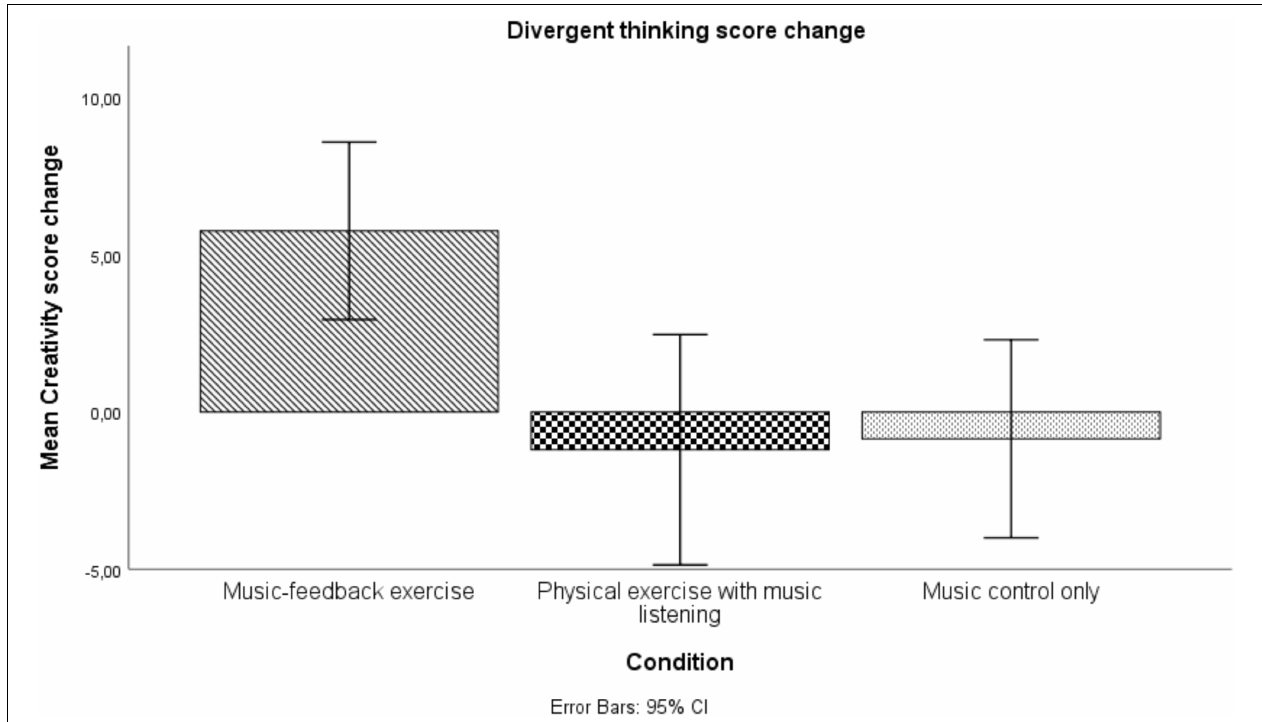
FIGURE 1 | Mean change in score from pretest to posttest on a Guilford’s Alternative Uses task. Error bars represent the 95% confidence